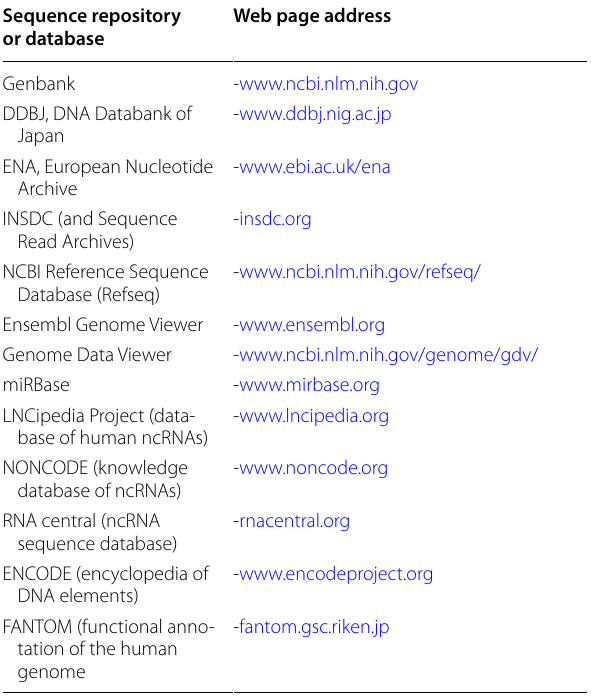
Shown are repositories, databases data viewers of nucleic acids. This is not an exhaustive list, and the selection only reflects authors’ preferences